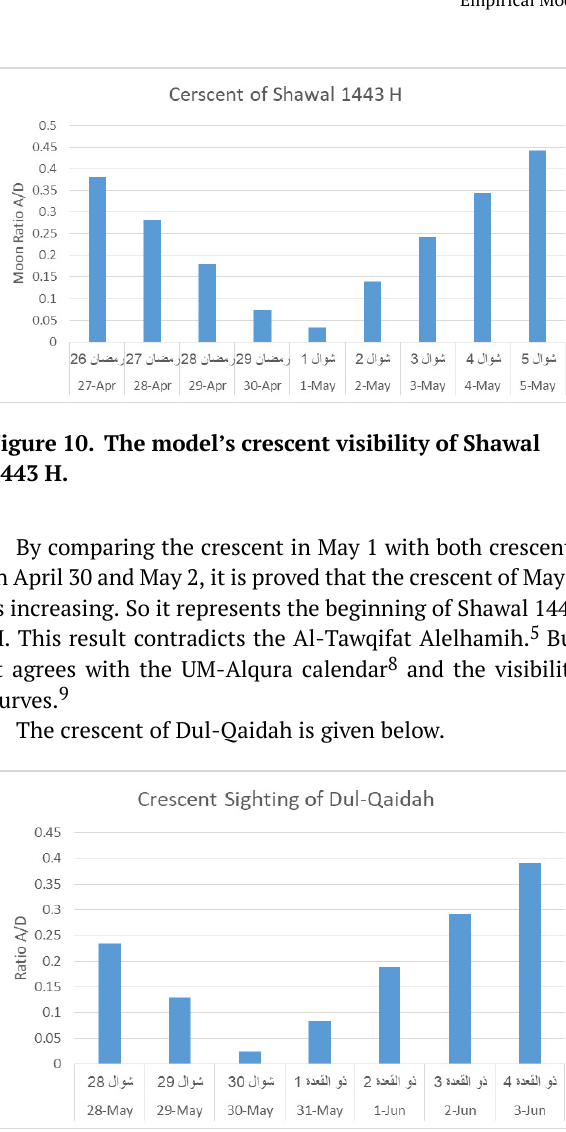
Figure 11. The model’s crescent visibility of Dul-